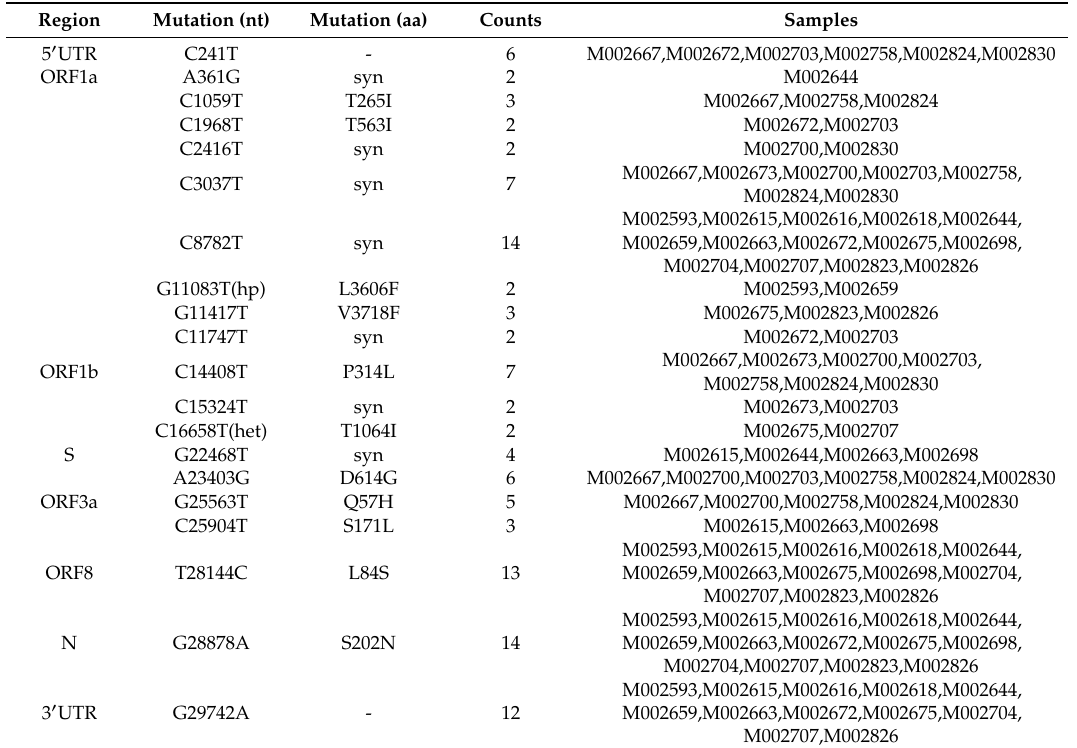
Table 1. Overview of observed mutations, which occurred in at least two patients. Het = heterozygous, hp = highly homoplastic, syn = synonymous. For full details, please refer to Table